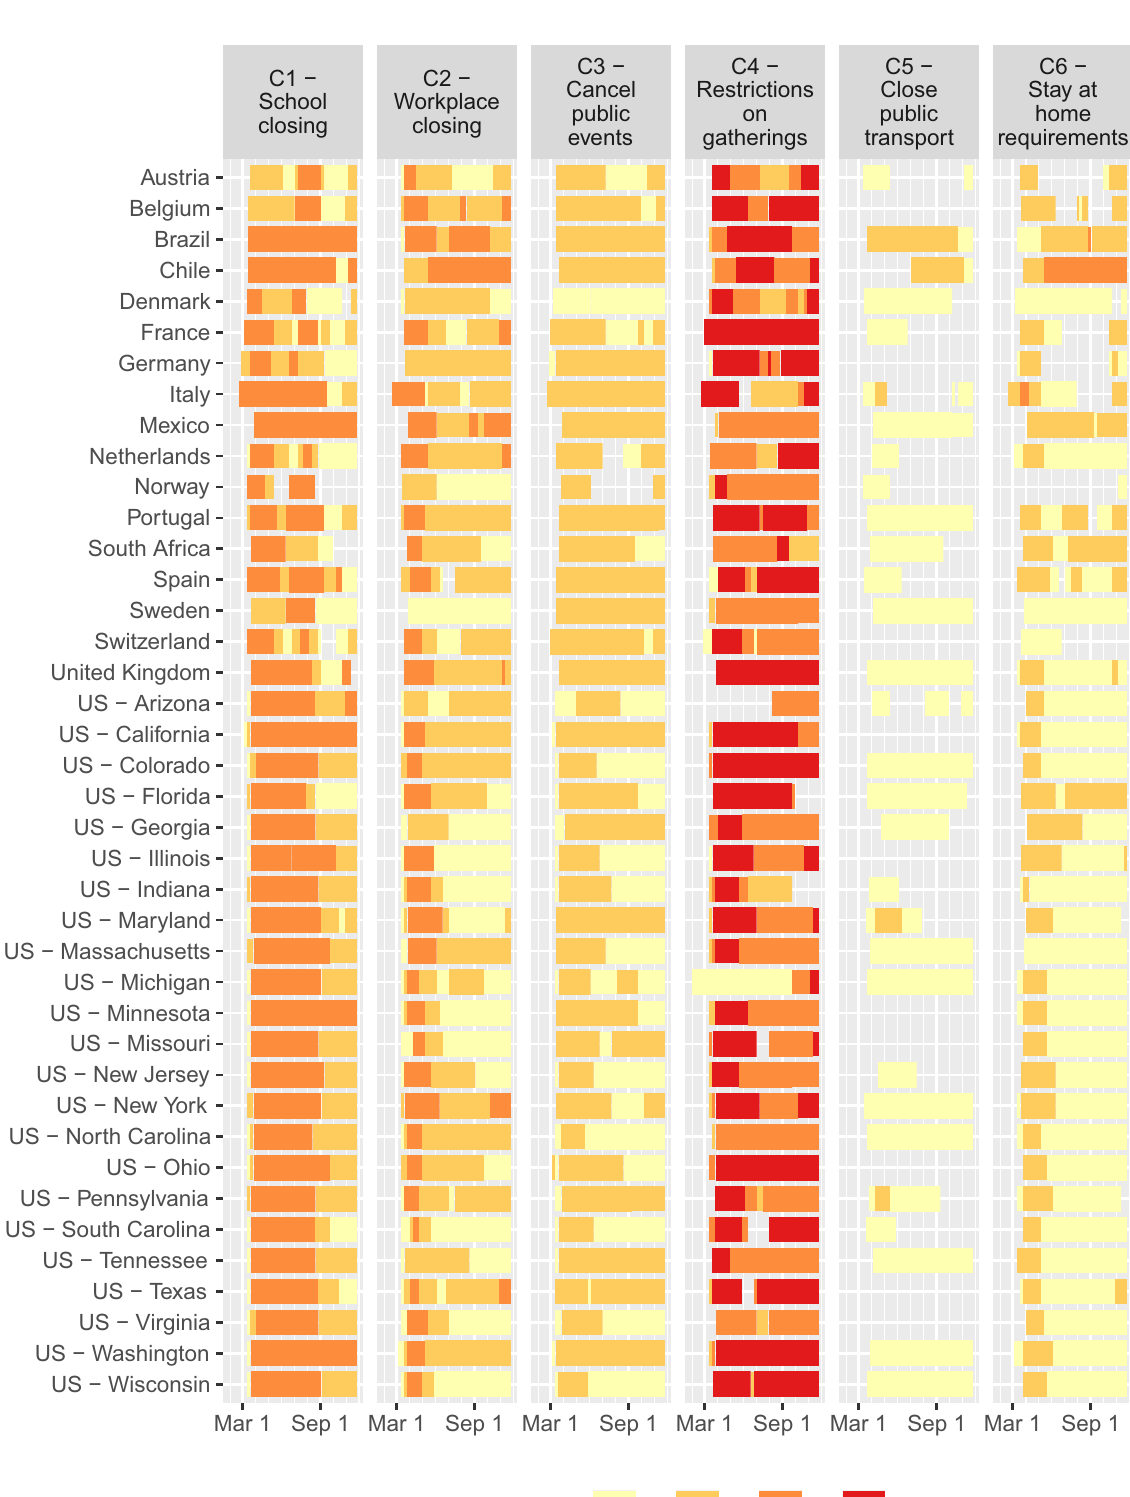
PLOS ONE | https://doi.org/10.1371/journal.pone.0244177 December29,